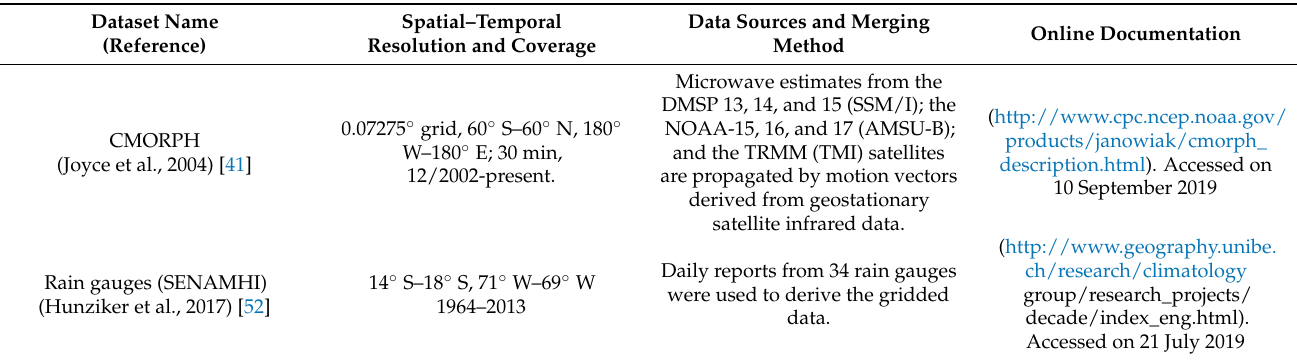
Table 1. Summary of precipitation data sets used in this study.